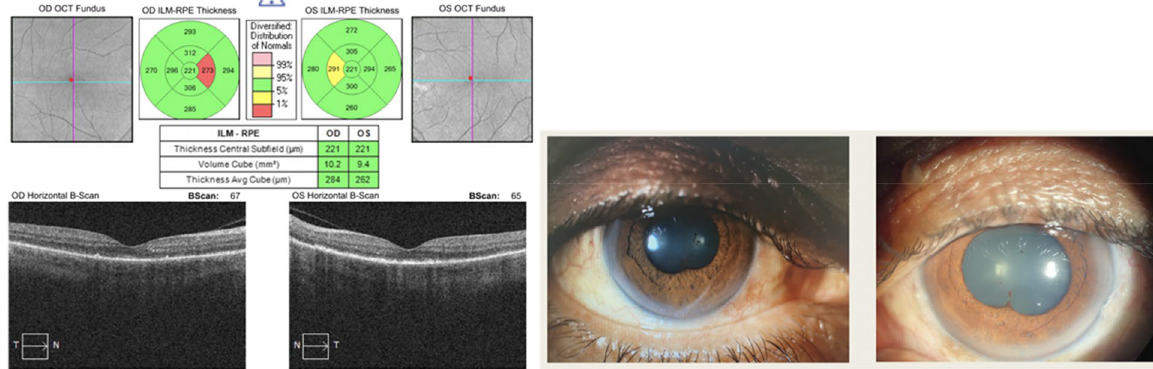
Fig. 9 21.10.21: BVCA